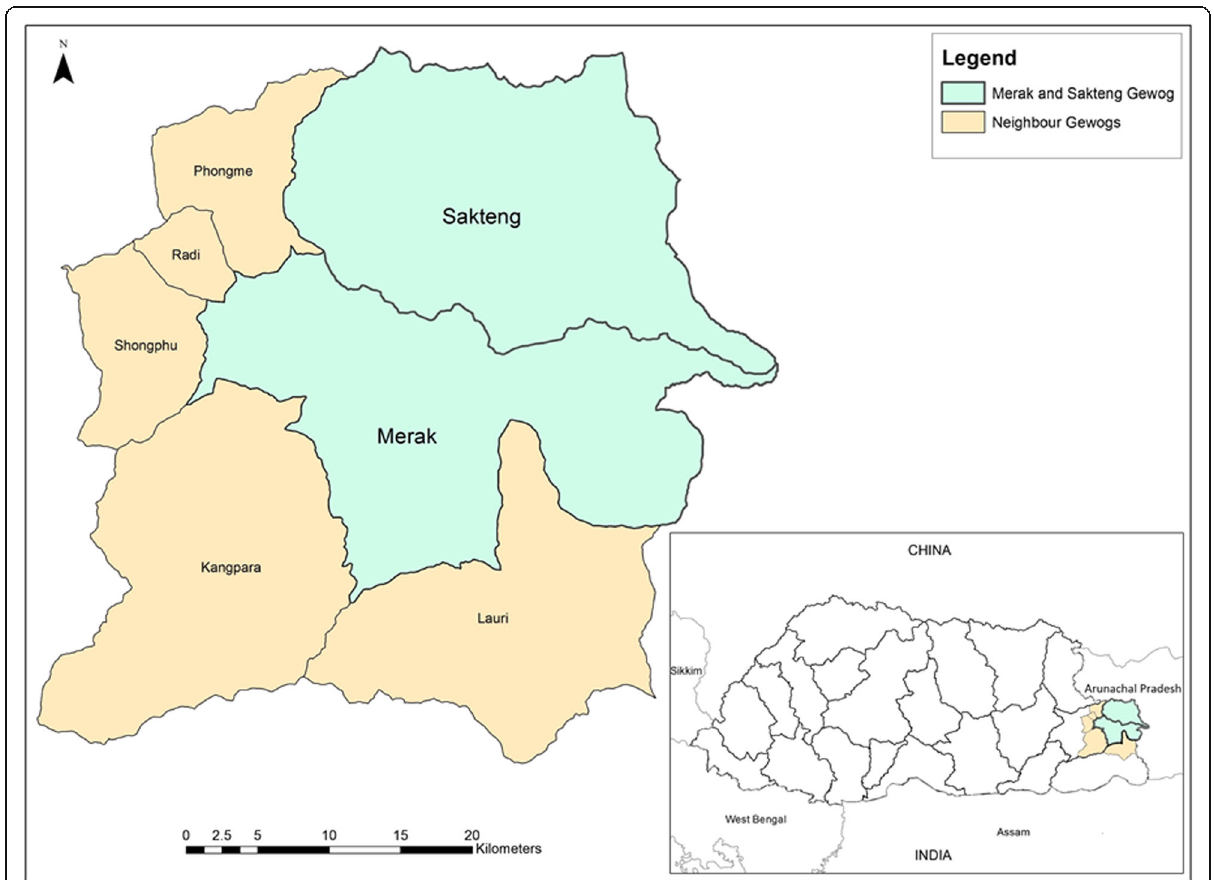
Figure 2 The study area and its geographical boundary with adjacent